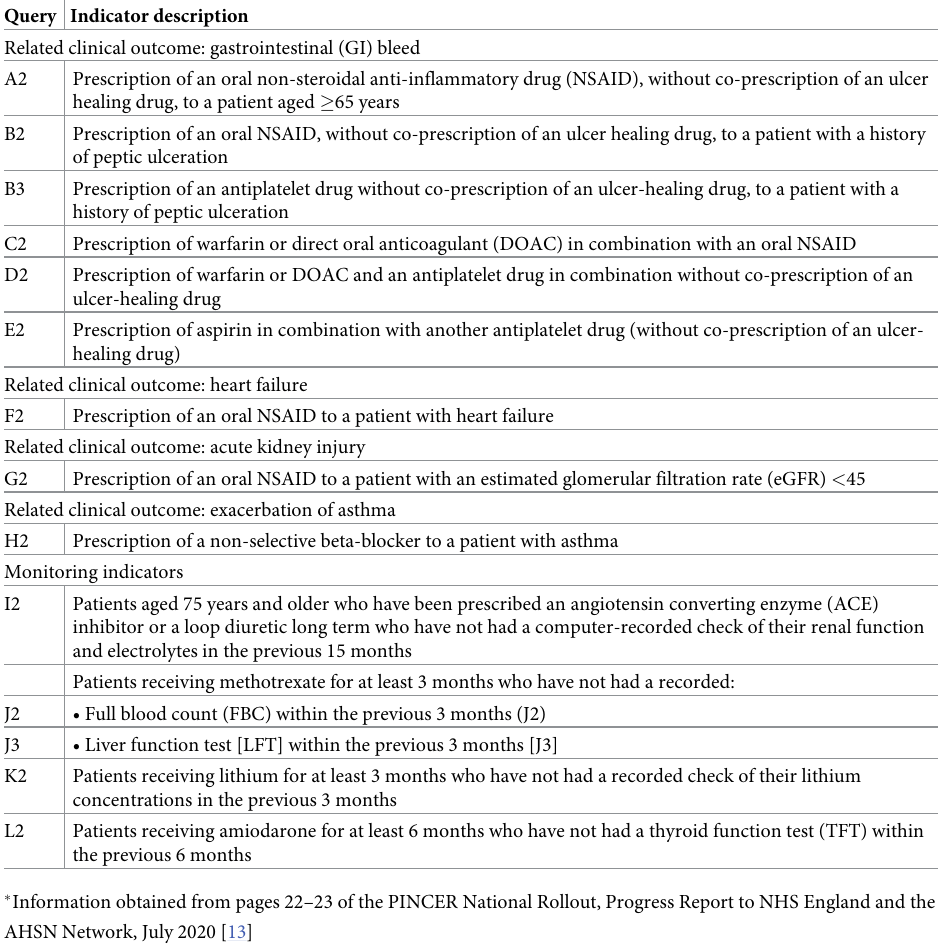
Table 1. Descriptions of the PINCER intervention indicators [13] �